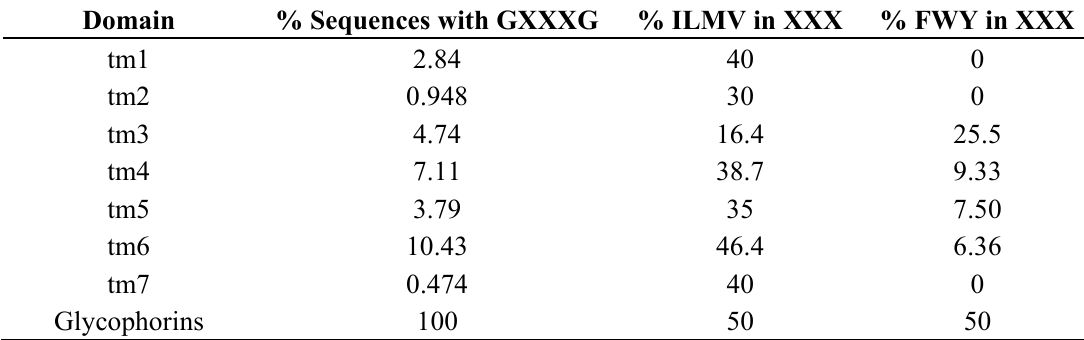
Table 2. GXXXG motifs in transmembrane domains of rhodopsin family human GPCRs and